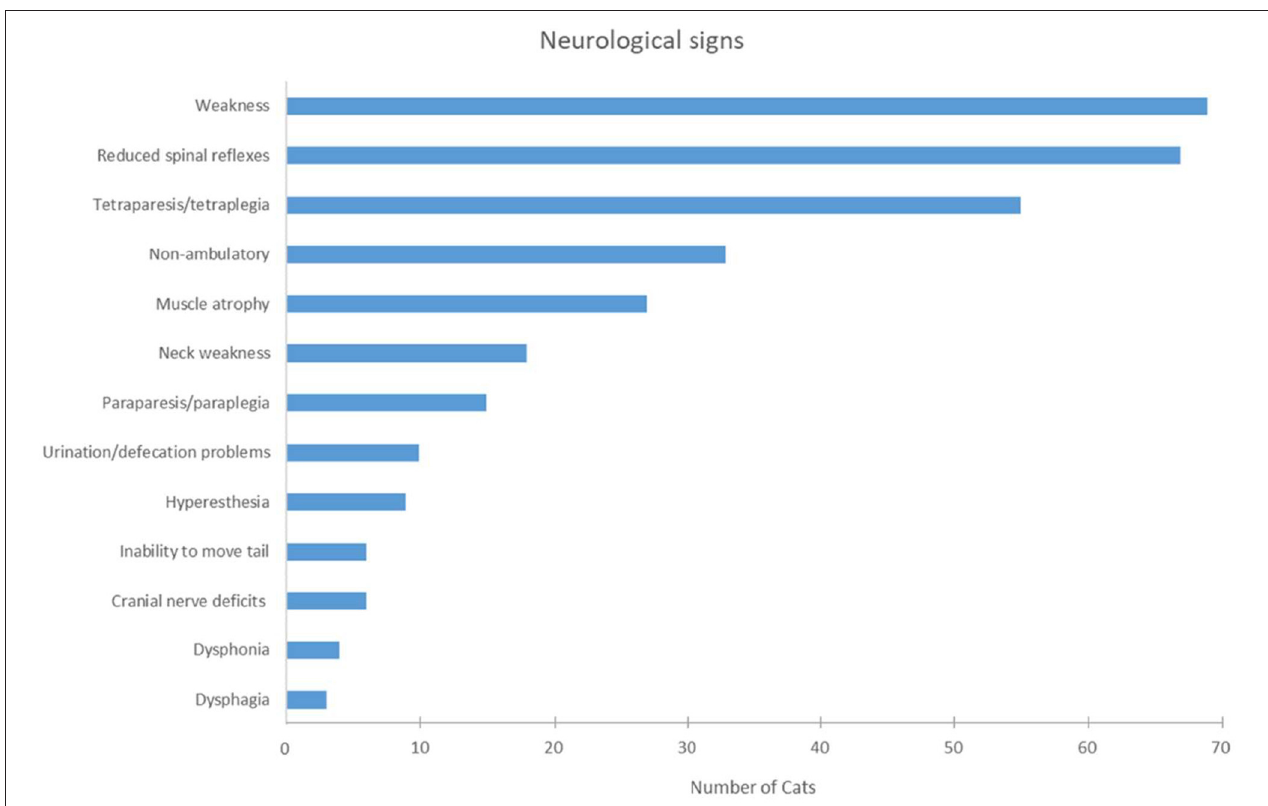
FIGURE 4 | Graphic representation of neurologic signs presented by the cats of this cohort.